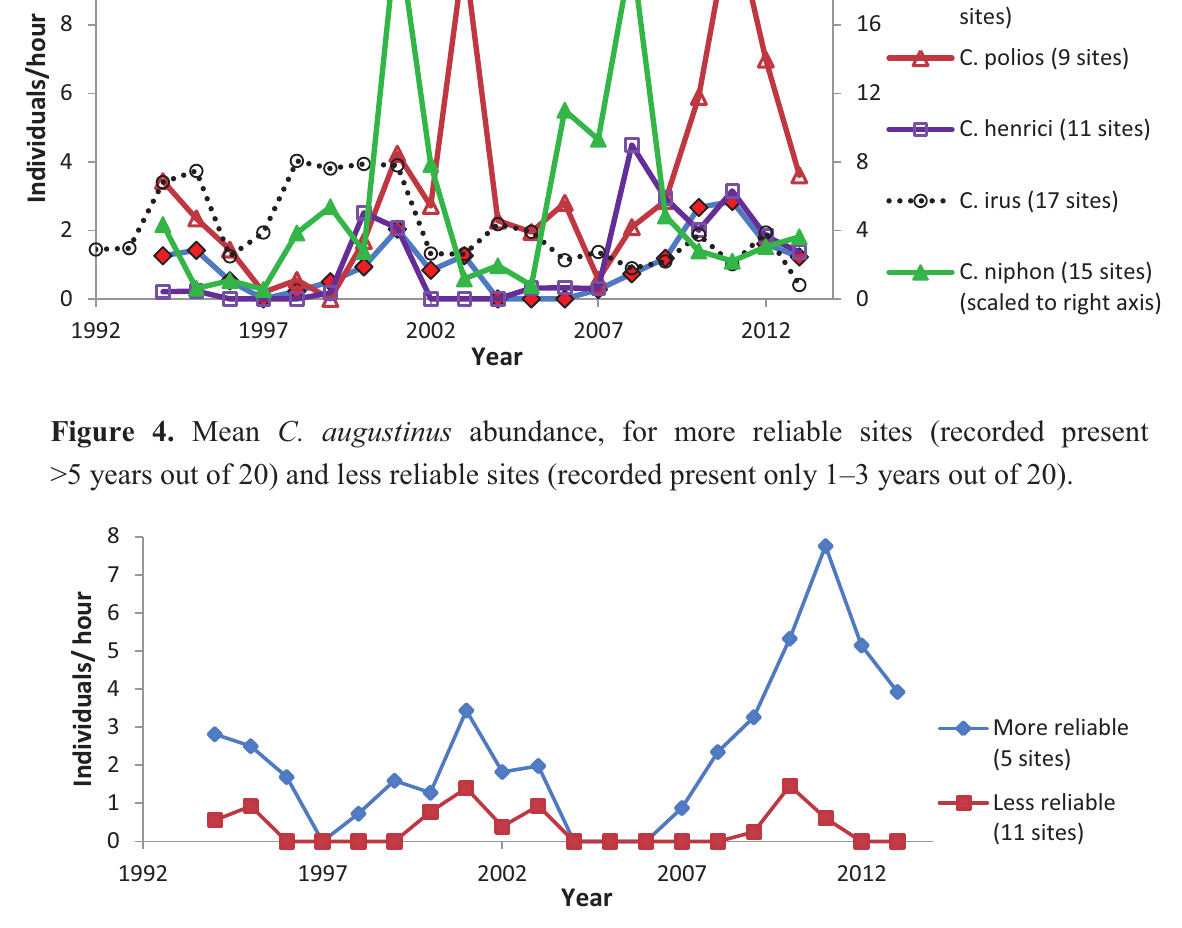
Figure 5. Mean C. polios abundance in the Bauer-Brockway cluster of sites compared to the other three long-term